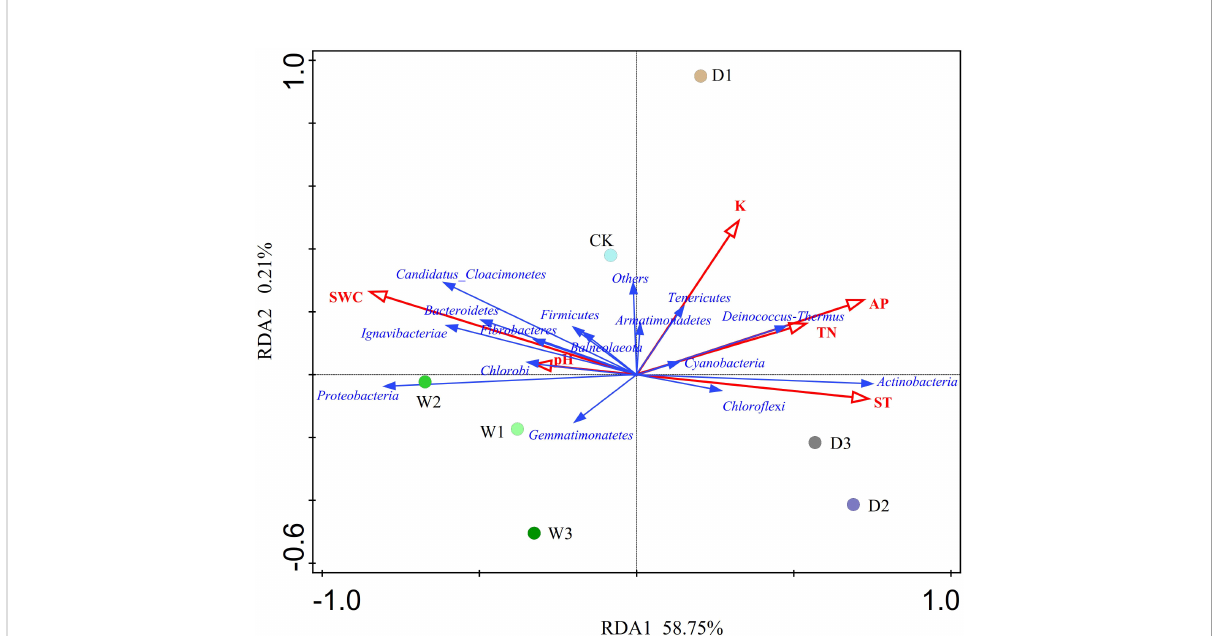
FIGURE 6 Redundancy analysis (RDA) of soil bacterial communities and environmental factors of different water conditions in alpine steppe on the Northern Tibet. Points denote sampling sites of seven precipitation gradients. The blue arrows represent soil bacteria (phylum), the red arrows represent environmental factors, and the cosine of the angle within two vector arrows represents the correlation between vectors. SWC, soil water content; AP, available phosphorus; K, kalium; ST, soil temperature; TN, total nitroge; P, phosphorus.